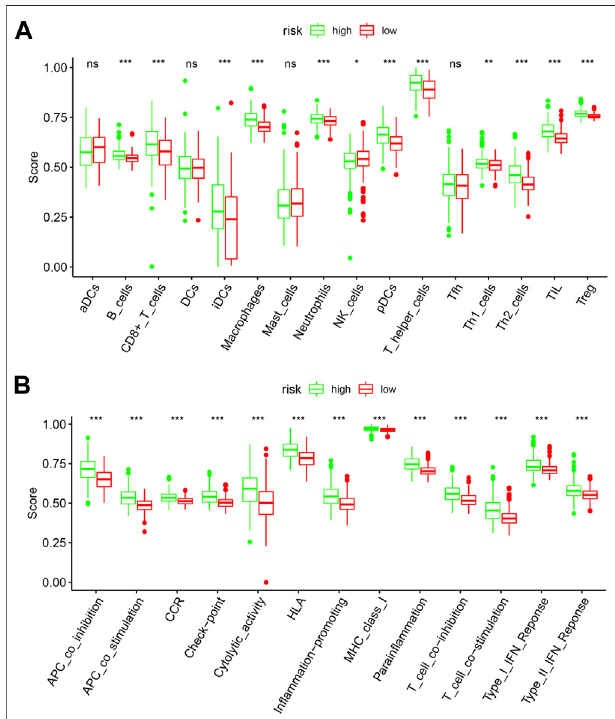
FIGURE 9 | Comparison of the ssGSEA scores between the high-risk andlow-riskgroups.Thescoreof16immunecells (A) and13immune-related functions (B) are displayed in boxplots. DCs: dendritic cells; iDCs: immature DCs; pDCs: plasmacytoid dendritic cells; TIL: tumor-in fi ltrating lymphocyte; CCR: cytokine-cytokine receptor; APC: antigen-presentingcells. Adjusted p -values were shown as the following: ns, not signi fi cant; * p < 0.05; ** p < 0.01; *** p <